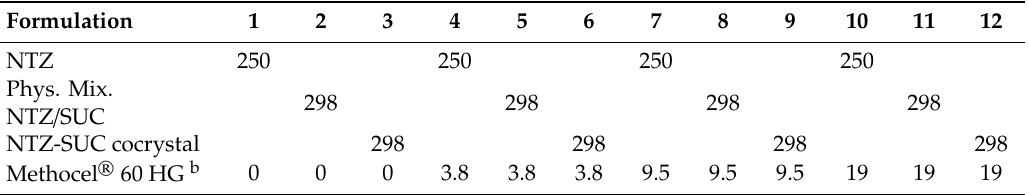
Table 1. Composition (mg) of powder formulations with and without Methocel ® 60 HG for NTZ, the physical mixture of NTZ and succinic acid (SUC) (2:1), and the NTZ-SUC cocrystal (2:1) a .